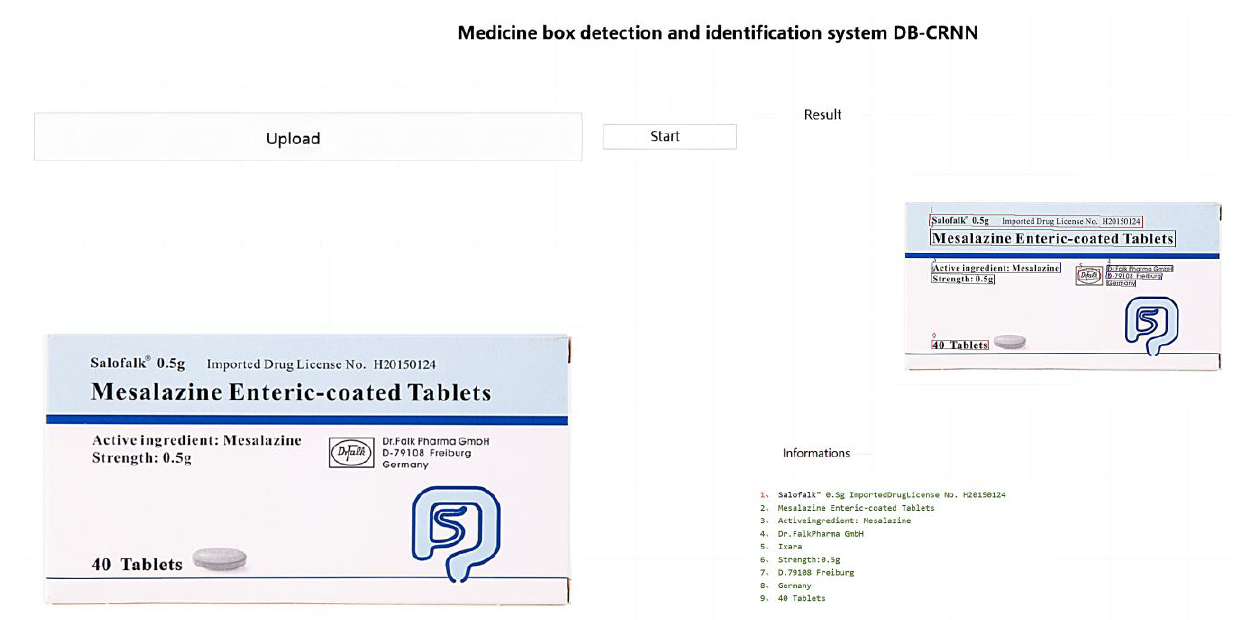
Figure 13. Pill box identification process and identification results.